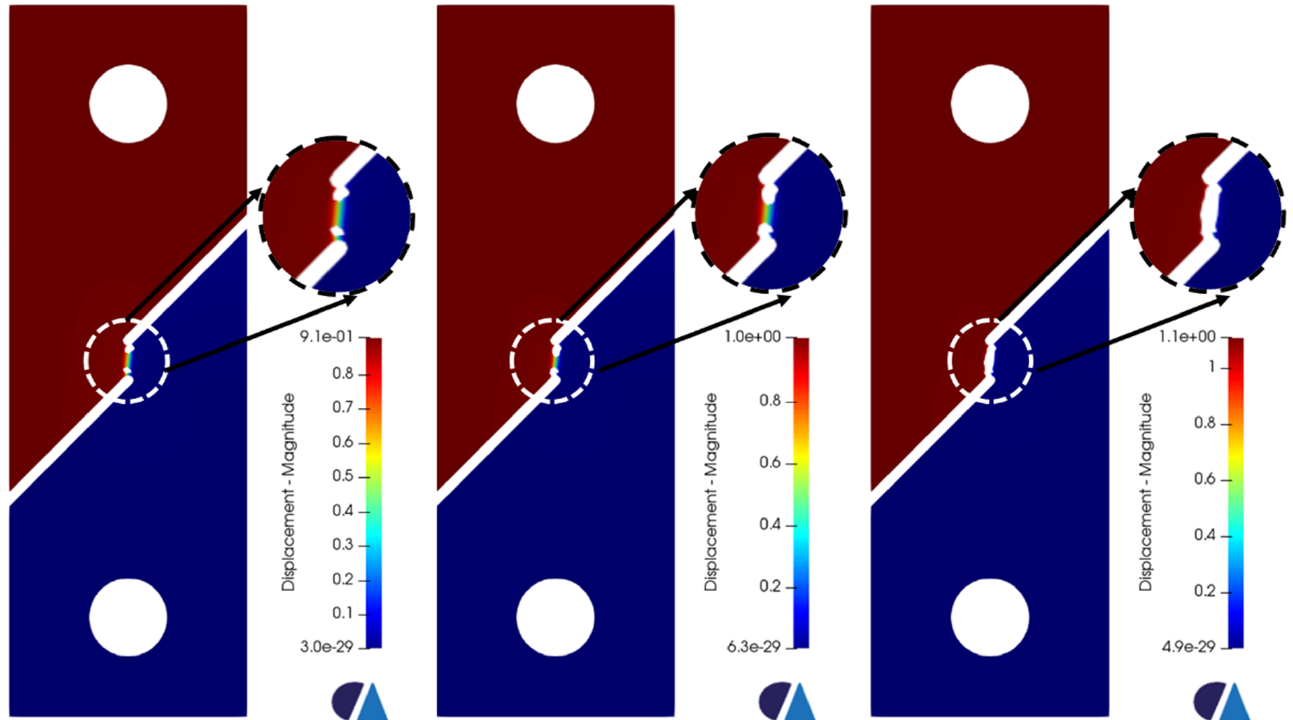
Figure 10. Fracture and failure progression in the shear sample with an incremental increase in displacement. The displacement values are in mm.